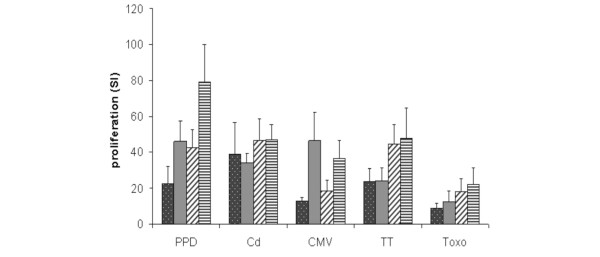
Proliferative responses to recall antigens in patients with immune-mediated inflammatory disease. The proliferative response to purified protein derivative (PPD), Candida (Cd), cytomegalovirus (CMV), Tetanus toxoid (TT), and Toxoplasma gondii (Toxo) was evaluated using the thymidine incorporation assay. Patients were from group I (dotted boxes) (n = 28) and from group II (gray shaded boxes) (n = 26), before TNF (tumour necrosis factor) antagonist administration, and from group III (diagonally lined boxes) (n = 20) and from group IV (horizontally lined boxes) (n = 14). Results are expressed as stimulation indices (SIs) (mean ± standard error of the mean). P > 0.05 for all comparisons between groups I and III and between groups II and IV, Mann-Whitney U test.